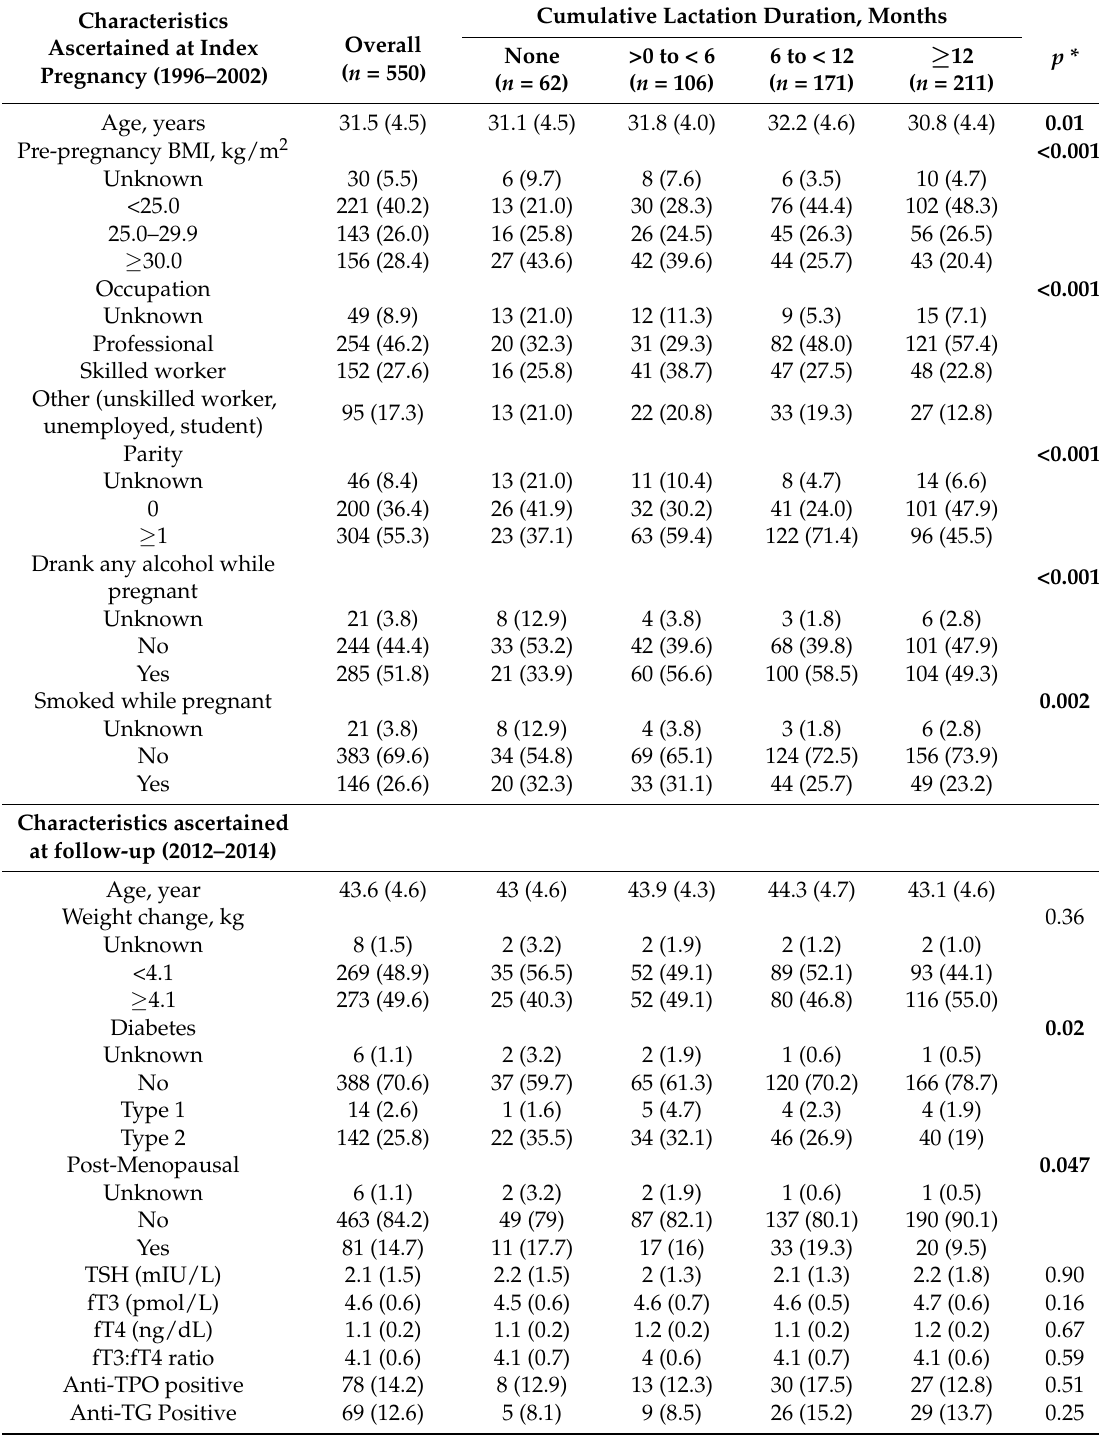
Table 1. Participant characteristics overall and by lactation history from the Diabetes & Women’s Health